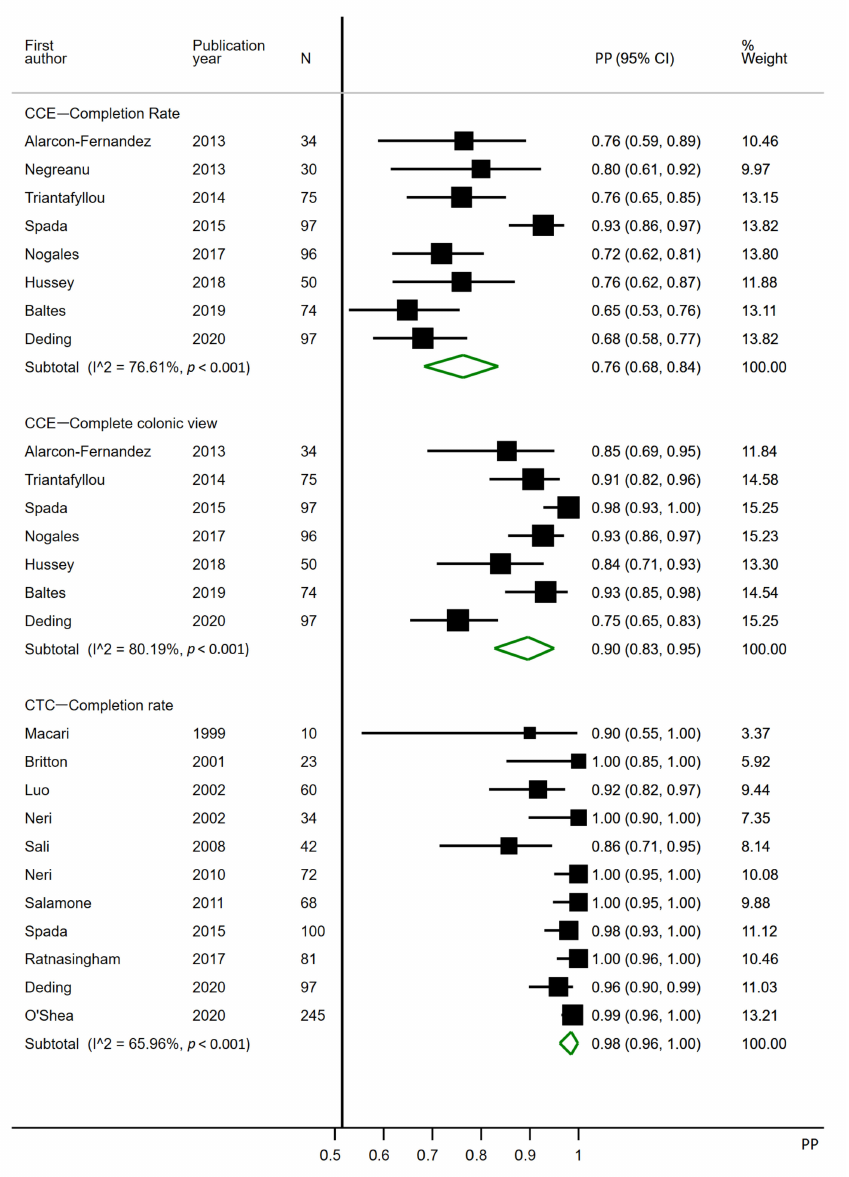
Figure 2. Forest plot for the completion rates of colon capsule endoscopy and CT colonography following incomplete colonoscopy. PP: estimated prevalence proportion. Complete colonic view: CCE investigations complete or overlapping with the most proximal point of a previous incomplete